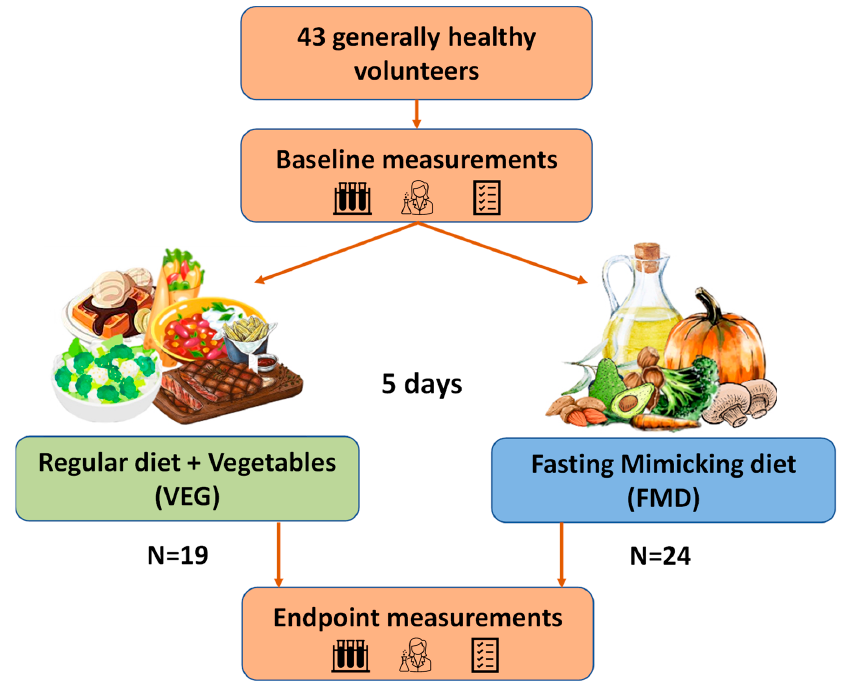
Figure 1. Schematic representation of the study design. Table 1. Baseline data characterizing bio-anthropometric and biochemical parameters of the study participants.